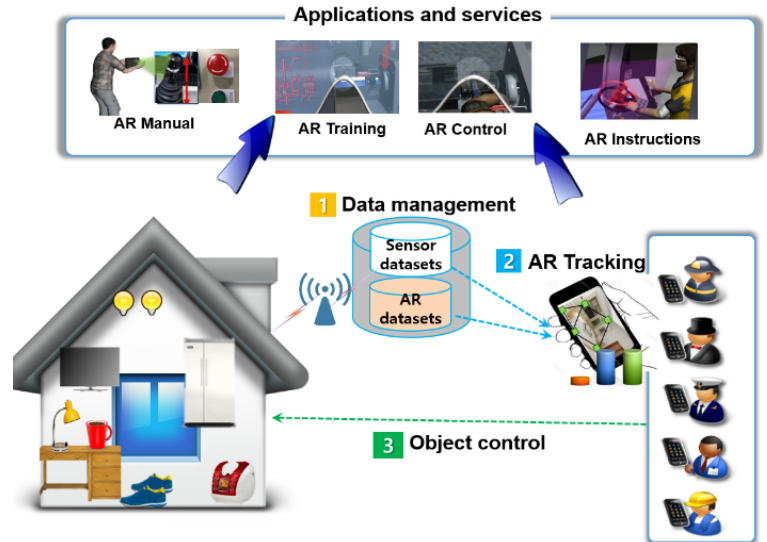
Figure 3. Internet of Things (IoT) combined with augmented reality (AR): overall possible architecture based on which smart and interactive AR services can be defined.